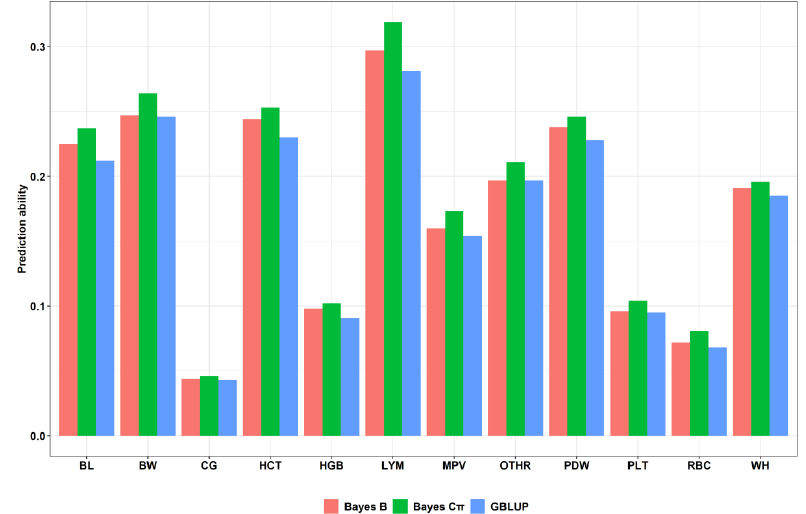
Figure 1. Accuracy of prediction of three methods for 12 target traits. Note: Colors represent the different methods. The abscissa represents different traits and methods. The ordinate is the corresponding prediction capability.